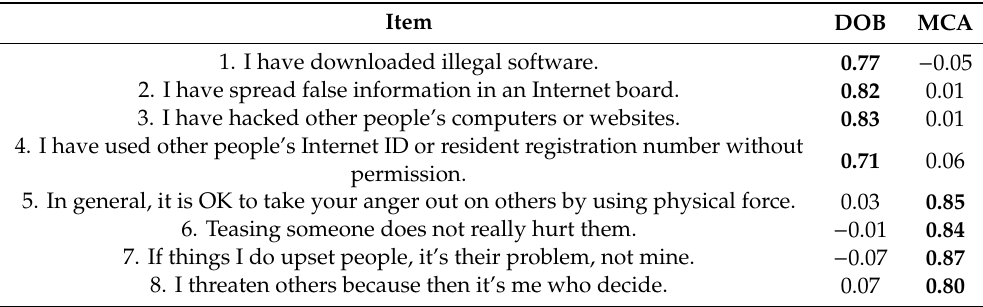
Table 1. Factor loading resulted from exploratory factor